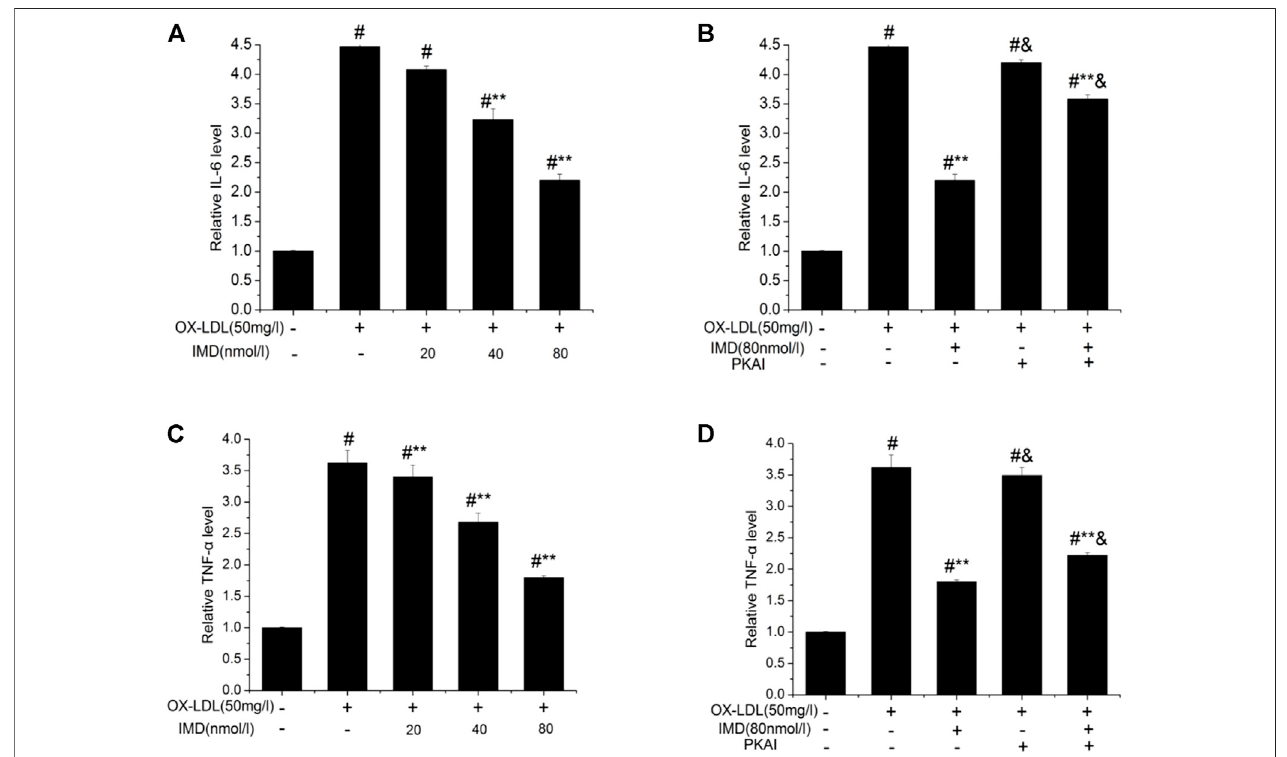
FIGURE 5 | IMD inhibits the protein expression of IL-6 and TNF- α in ox-LDL – induced macrophages (ELISA). # Compared with the control group ( p < 0.05); ** compared to the ox-LDL alone group ( p < 0.05); & compared to the ox-LDL +IMD group ( p < 0.05).